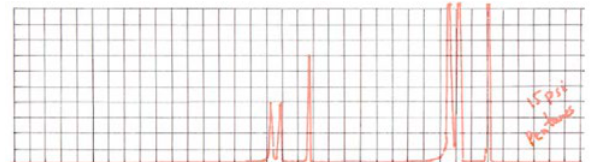
Figure 7. M. Golay´s one of the first chromatograms with a cap- illary column measured in 1956, separating a mixture of isomeric pentanes. Column: 366 cm length, 1.37 mm i.d.; stationary phase (coating the inner capillary wall), polyethyleneglycol; isothermal at room temperature. Detection with miniaturized thermal conductiv- ity detector. For details see Supplementary Information and ref. [61] . From ref. [61] with